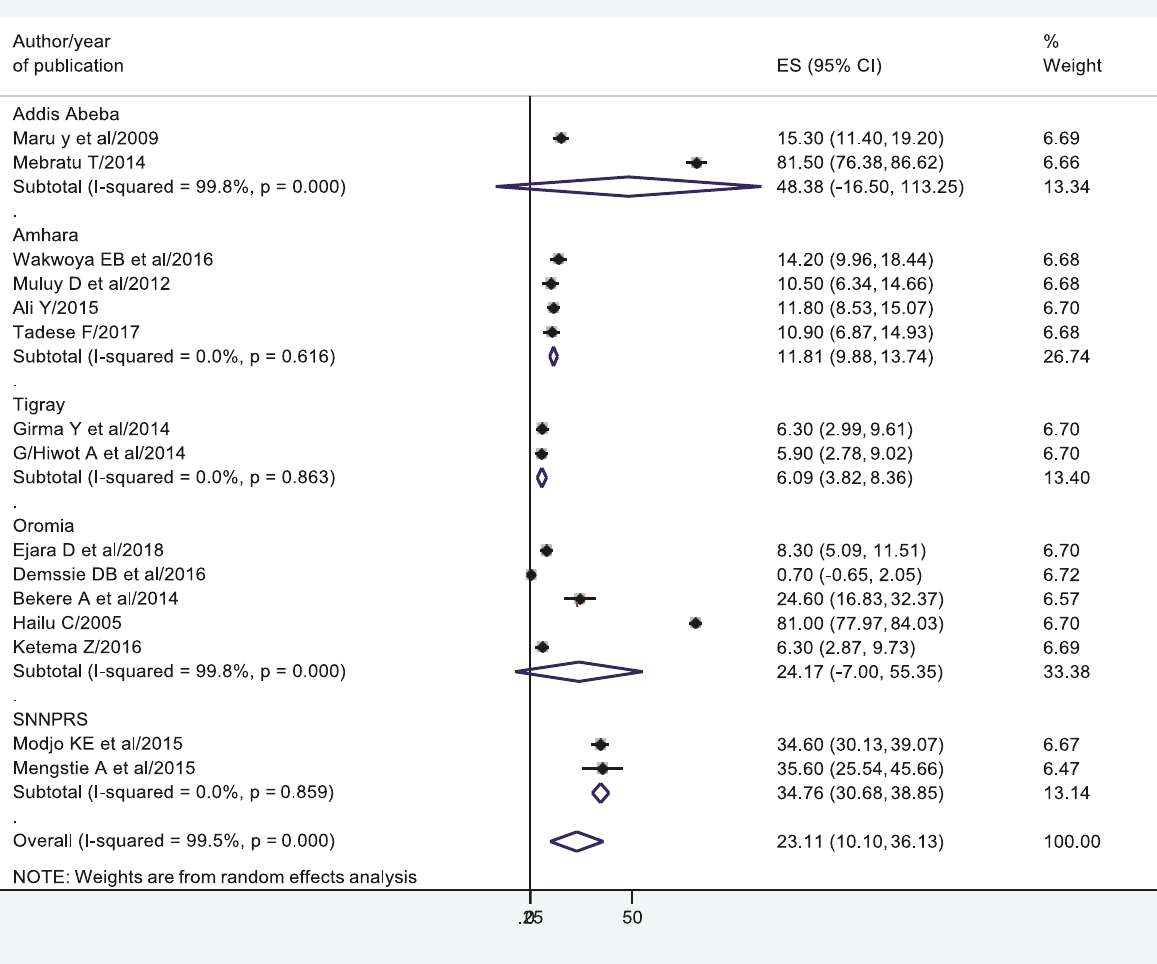
Figure 4: Forest plot of the prevalence of mixed feeding by region with 95% CI. The midpoint and the length of each segment revealed the prevalence and 95% CI of each study whereas the diamond shape showed the combined